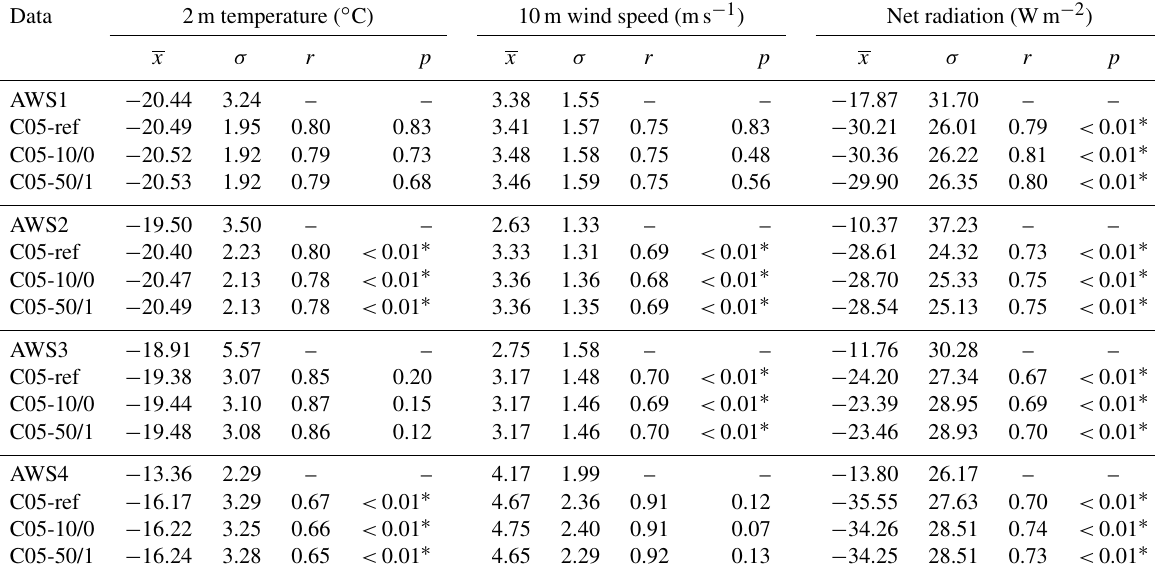
Table 3. Statistical comparison of 2m temperature, 10m wind speed (3m in case of the AWS), and net radiation ( K ∗ + L ∗ ) of the four AWS and the C05 simulations: C05-ref (reference), C05-10/0 (open water), and C05-50/1 (realistic). Hourly means are denoted by x and standard deviations are denoted by σ . The Pearson correlation coefficient ( r ) was calculated with the AWS and C05 time series. The critical correlation coefficient ( α = 5%), which depend on the sample size of the AWS time series, is between 0.1 and 0.2. In addition, the resulting p values ( p ) of two-sided t tests ( α = 5%) are shown. Significant differences are marked with ∗ . Data pairs with missing values in the AWS data or where the sea-ice concentration is < 95% were removed prior to the